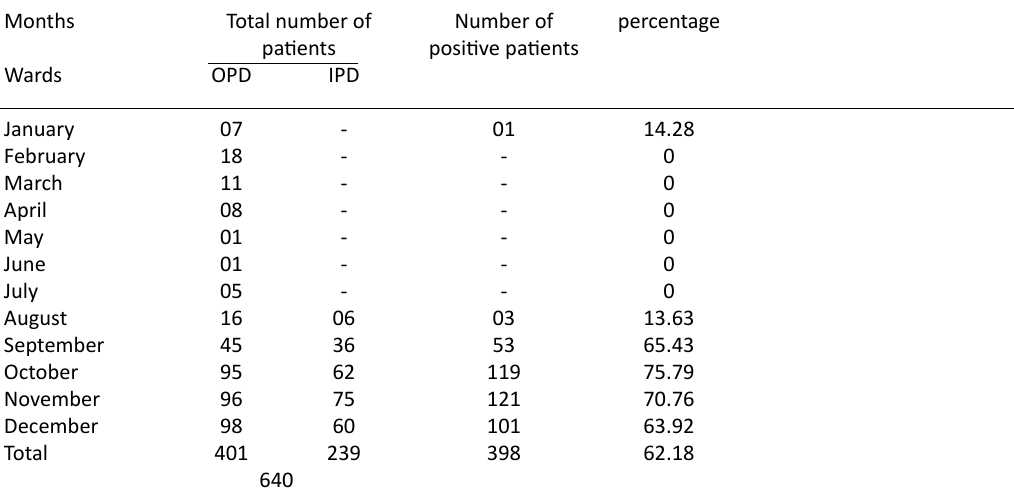
Table 4. Seasonal Variation of dengue Infections